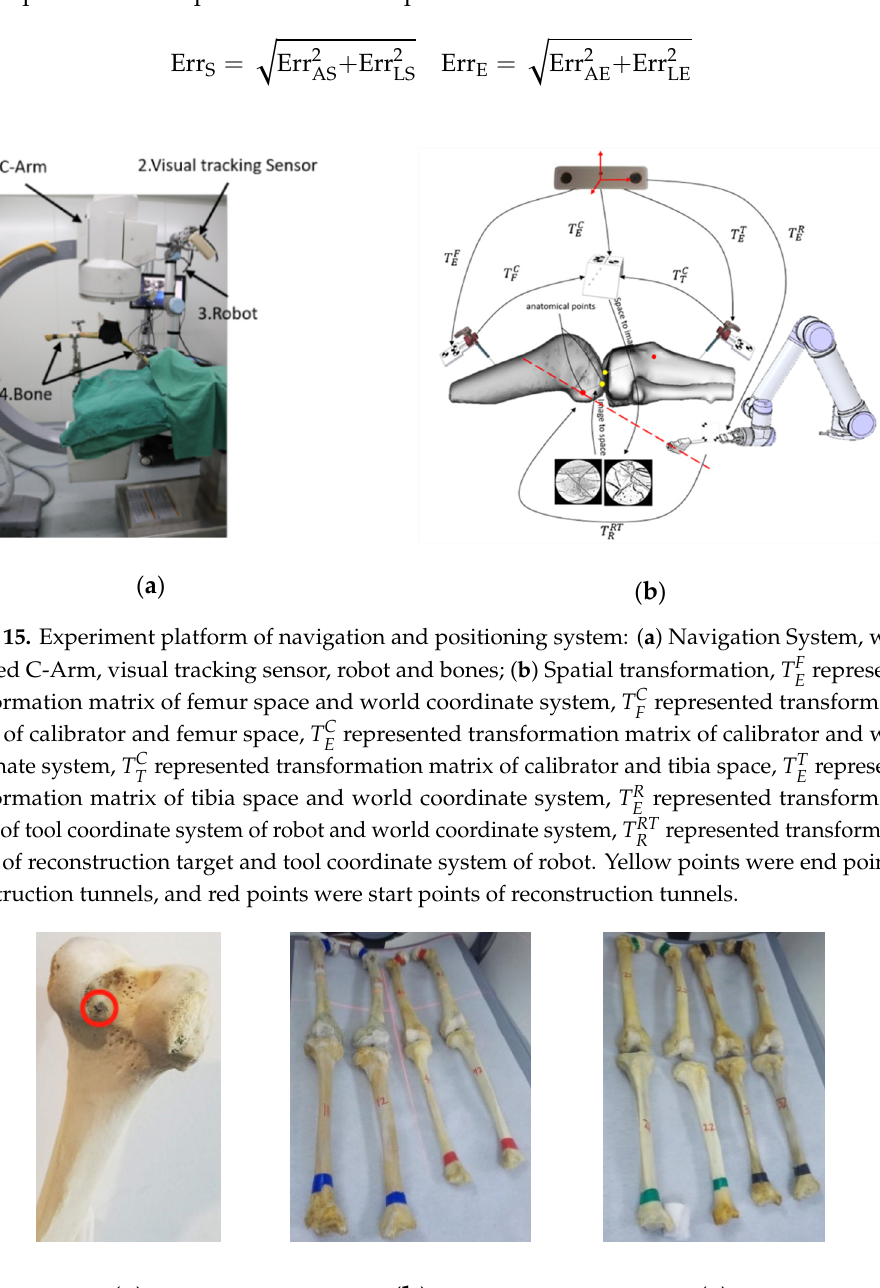
( b ) Figure 17. X-Ray images of positioning of the tunnels, planning tunnels through 2 steel balls was marked in yellow line and positioning tunnel was marked in red line: ( a ) Tibia planning tunnel; ( b ) Femoral planning tunnel. Table 2. Positioning Errors of the navigation system for ACL reconstruction. Positioning Errors (mm)